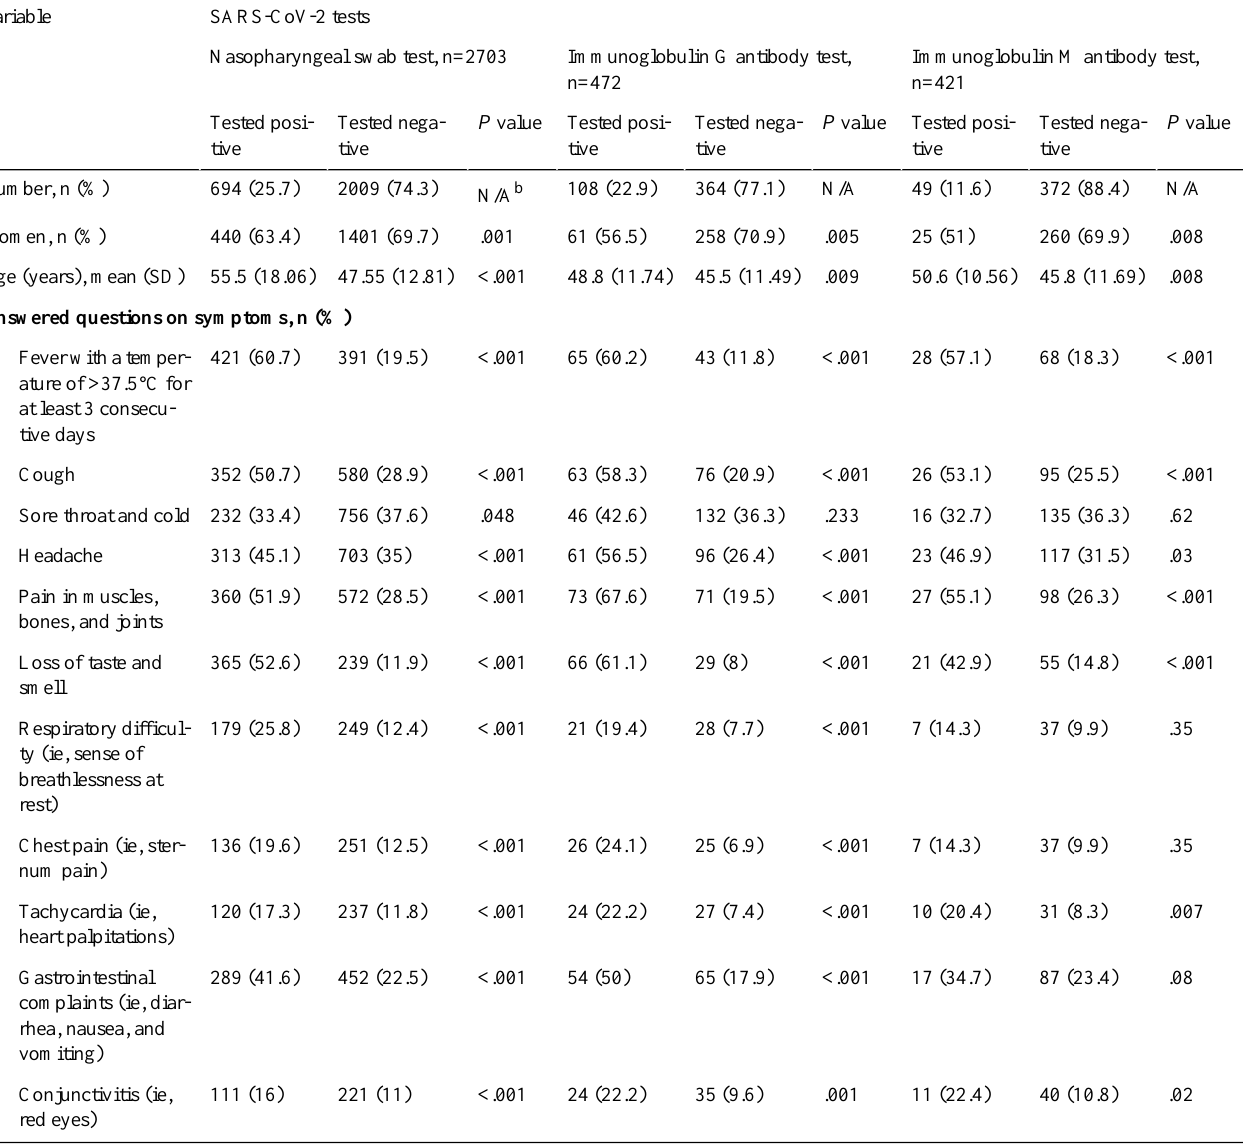
Table 1. Self-reported characteristics that were obtained from the Phase II survey and analyzed by using SARS-CoV-2 infection test results (N=2703). a